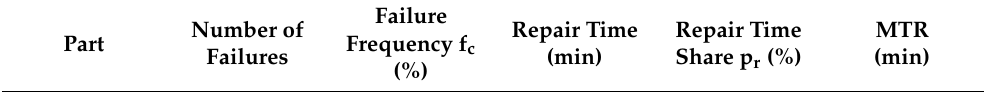
Table 1. Summary of failures and repair